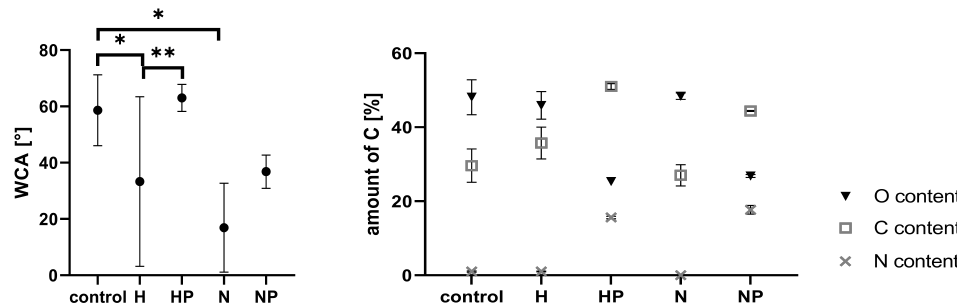
Figure 5. WCA and amounts of carbon, nitrogen and oxygen on Ti6Al4V surface after treatment with NaOH, H 2 O 2 , and PHMB, respectively. Treatment of the surfaces with NaOH and H 2 O 2 led to a significant reduction of WCA. Adsorption of PHMB and possible carbon contaminations led to increasing WCA. The carbon content was highest for the H 2 O 2 -PHMB (HP) surface, while exhibiting the lowest amounts of nitrogen and oxygen. The lowest carbon content was reached after treatment of the surface with NaOH. * p < 0.05, ** p < 0.01, *** p <